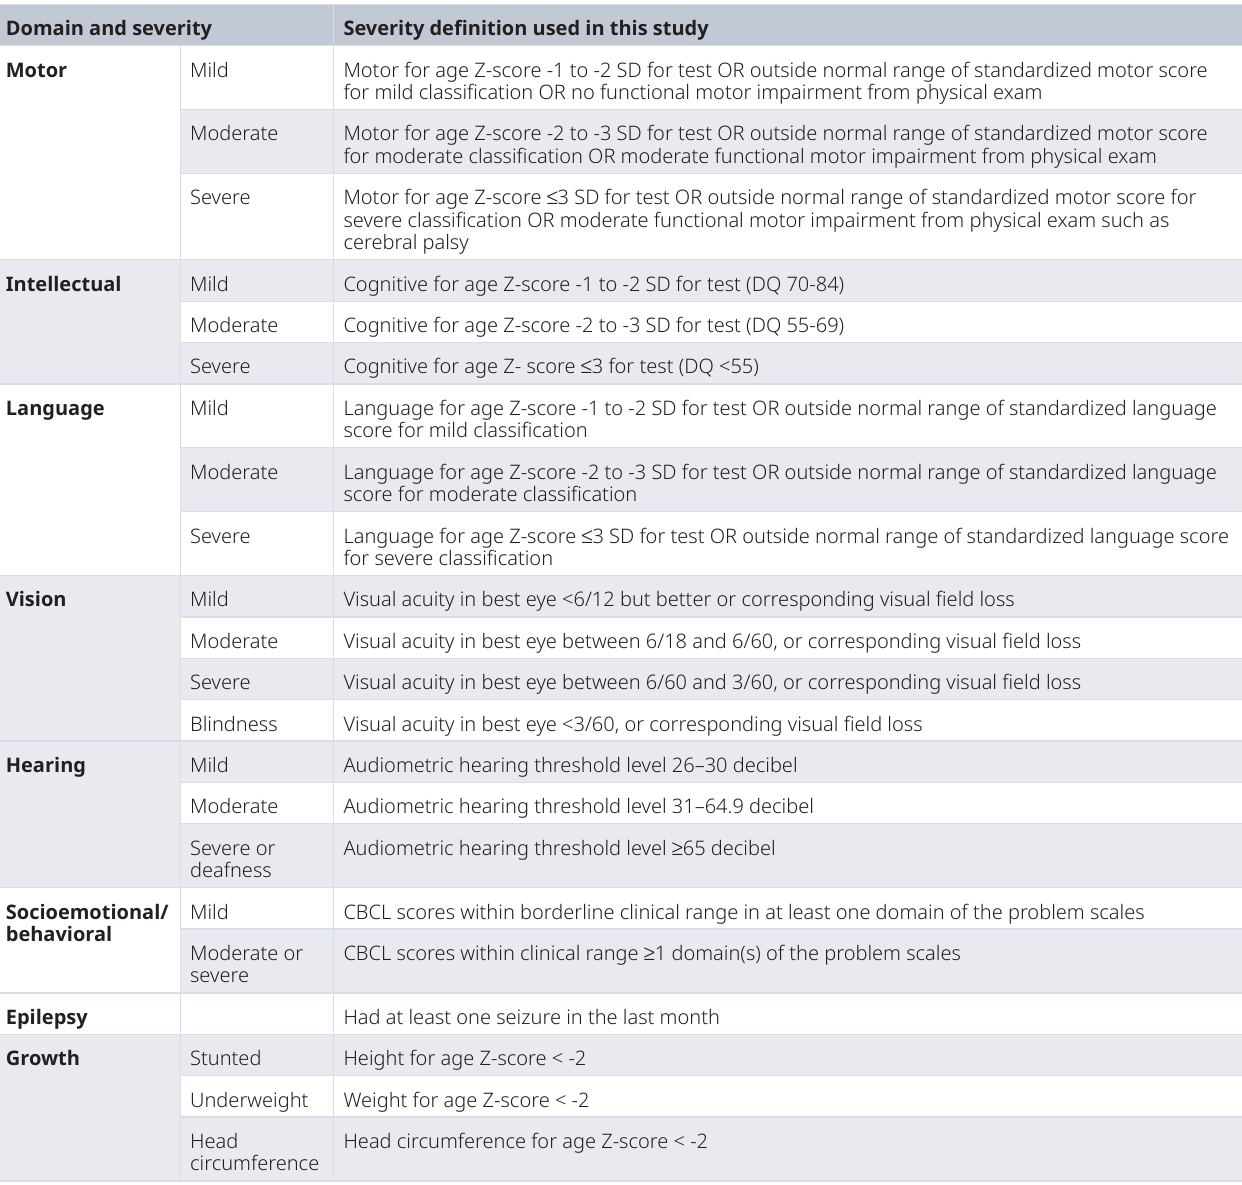
Table 7. Definitions of growth and domain specific neurodevelopmental impairment severity. Domain and